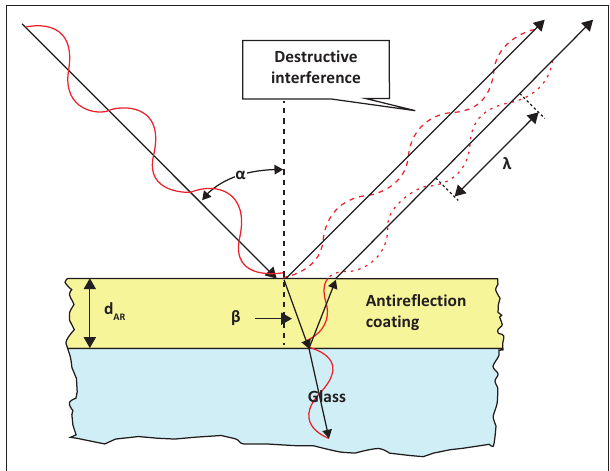
FIGURE 1: The principle of antireflection coatings (ARCs) showing destructive interference for a single wavelength λ in the reflected light of a transparent material. Light incident on a transparent air and thin ARC interface at angle α is refracted through angle β. A small percentage of the incident light is reflected. The refracted light incident on the ARC/glass interface is refracted into the glass whilst a small percentage is also reflected back through ARC and transmitted into the air. Assuming the path and amplitude conditions are satisfied, complete destructive interference will take place in the reflected light. No energy is lost. The energy is re-channelled through to the transmitted light.